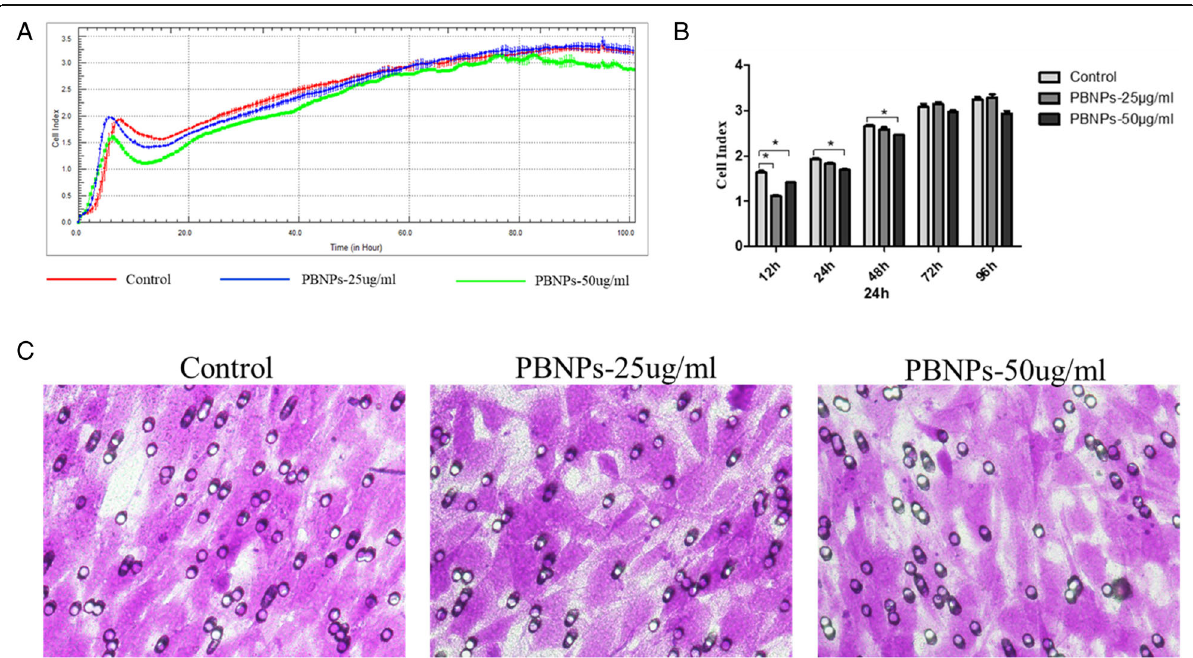
Fig. 5 The migration of C3H10T1/2 cells in the presence of various amounts of PBNPs. a The migration of C3H10T1/2 cells determined by RT-CIM assay. b The cell index of C3H10T1/2 cells after treating in 12, 24, 48, 72, and 96 h. c The migration of C3H10T1/2 cells determined by Transwell assay (magnification ×